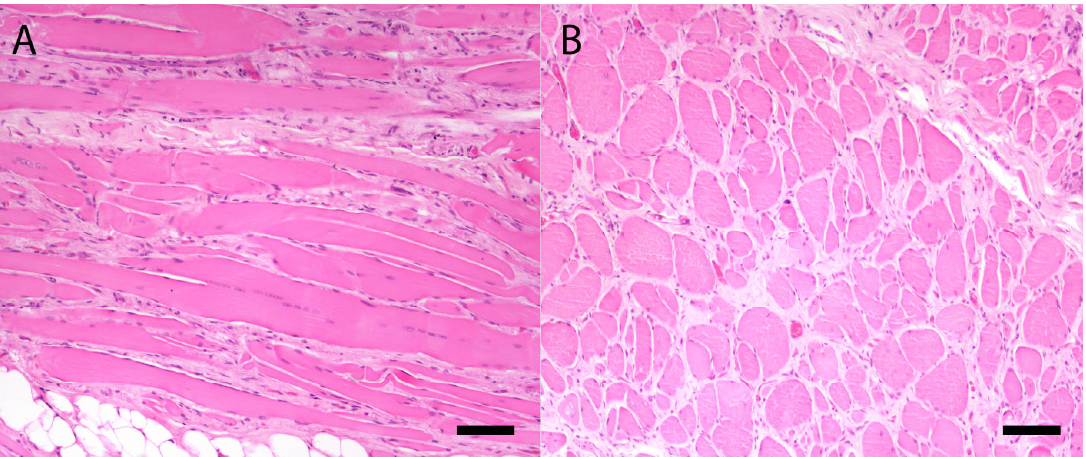
Figure 2. Longitudinal section of diaphragm stained with hematoxylin-eosin (H&E) ( A ), showing the rows of nuclei in the fibers (regeneration) and fiber splitting. ( B ). Cross-section of diaphragm stained with H&E showing marked atrophy in some muscle fibers and hypertrophy in others, and fiber splitting. A diffuse and mild fibrosis was also present. Bar = 100 micron.